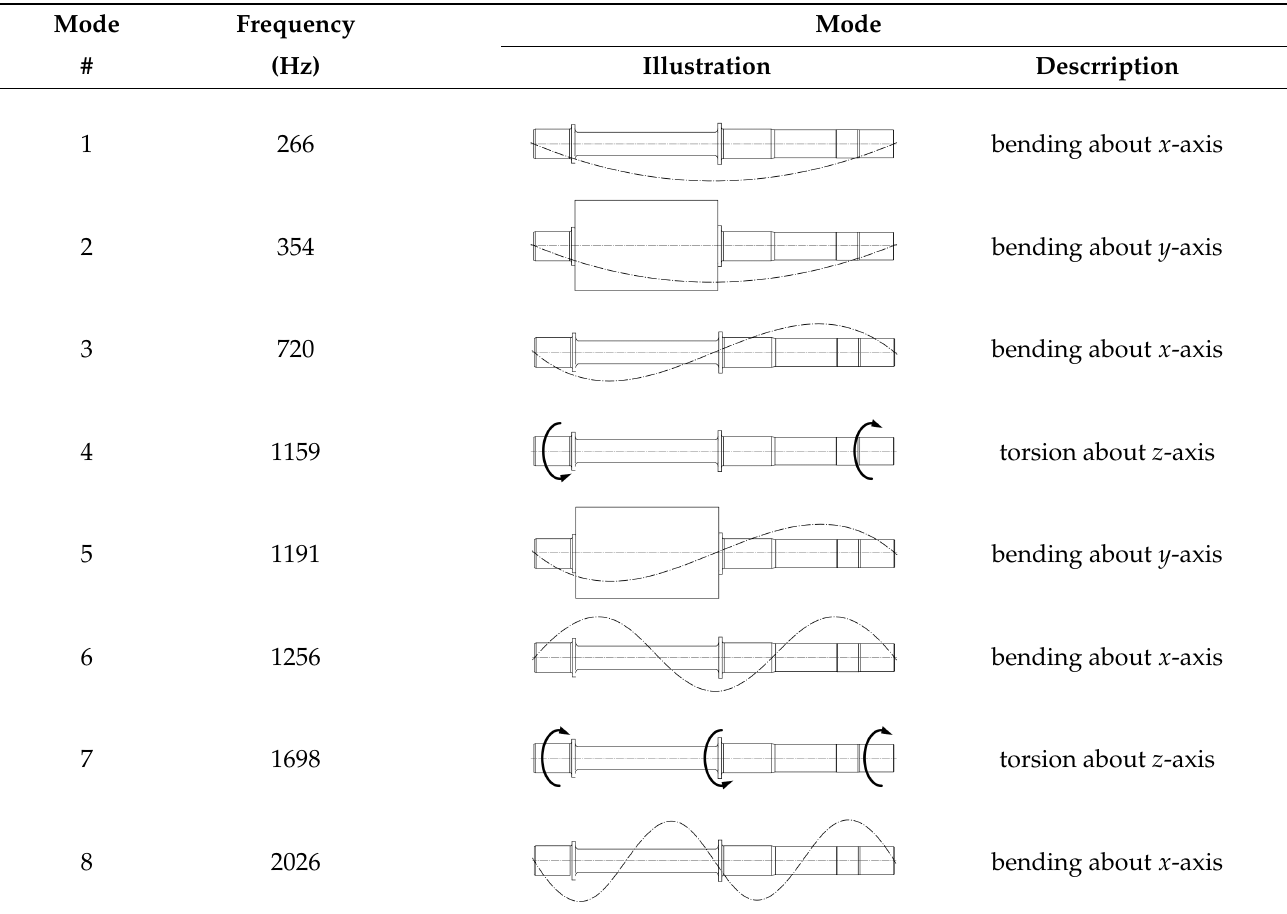
Table 7. Eigenfrequencies of the guide vane and their